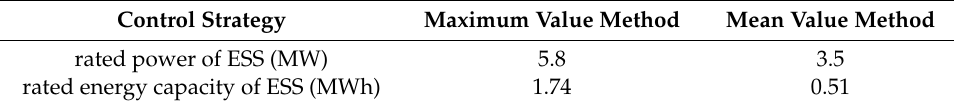
Table 3. The rated power and energy capacity of different control strategies.